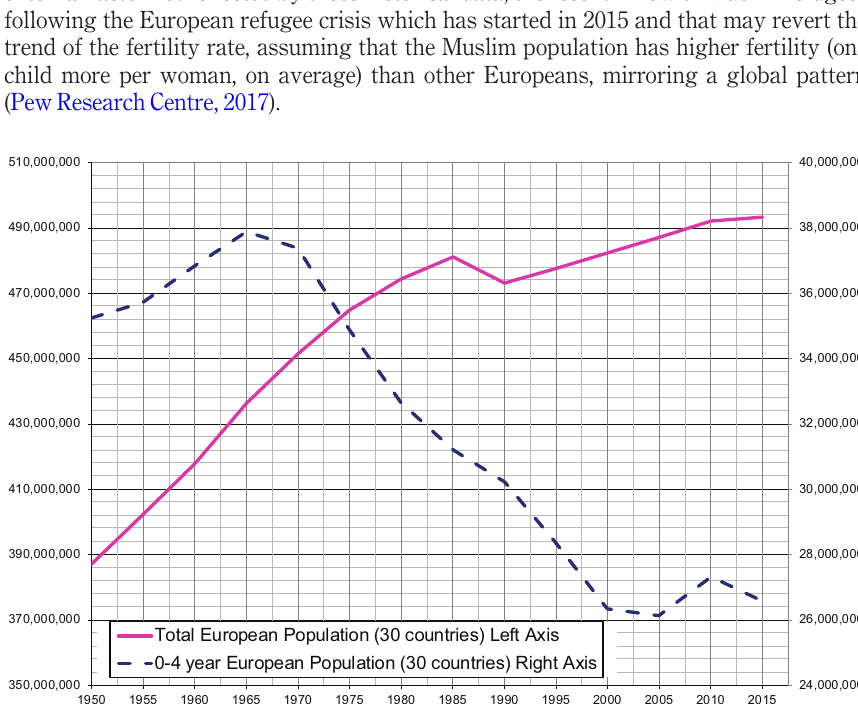
Figure 1. The European total population and the